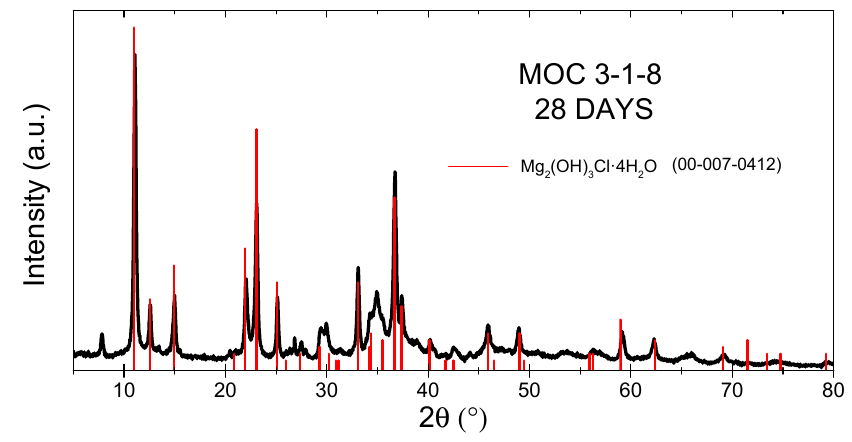
Figure 4. X-ray di ff ractogram of MOC 3-1-8 after 28 Figure 4. X-ray diffractogram of MOC 3-1-8 after 28 days. Figure 4. X-ray diffractogram of MOC 3-1-8 after 28 days.